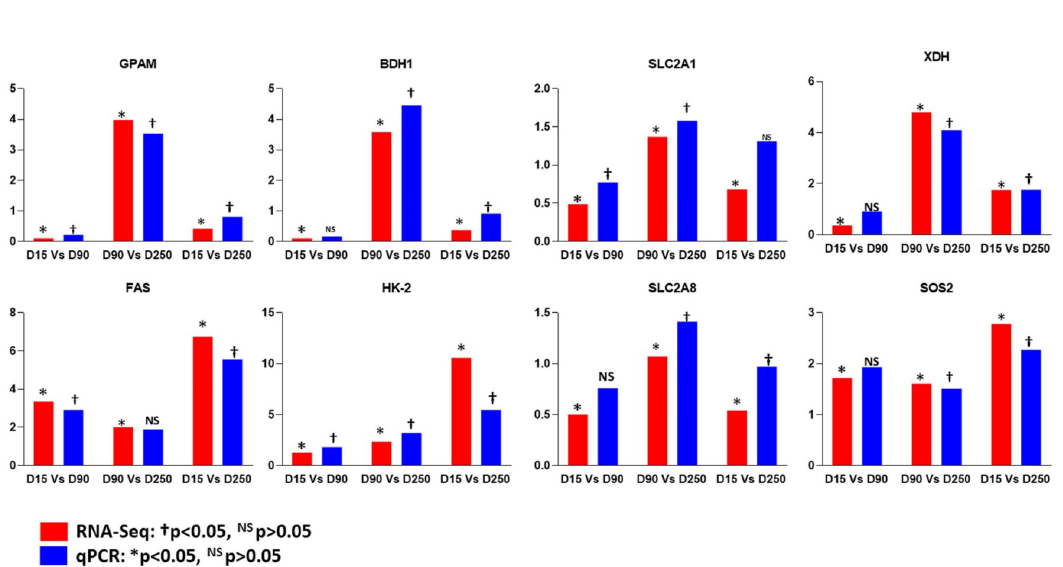
Fig 5. Comparison of the expression levels of eight differentially expressed genes obtained by RNA-seq and qPCR detection methods.